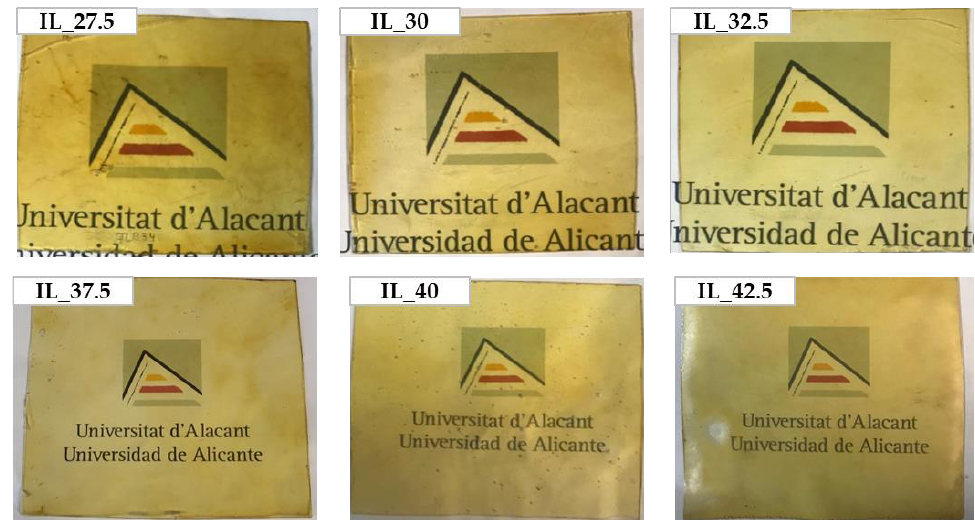
Figure 1. The visual aspect of starch/PVA blends plasticized by [Emim + ][Ac − ].